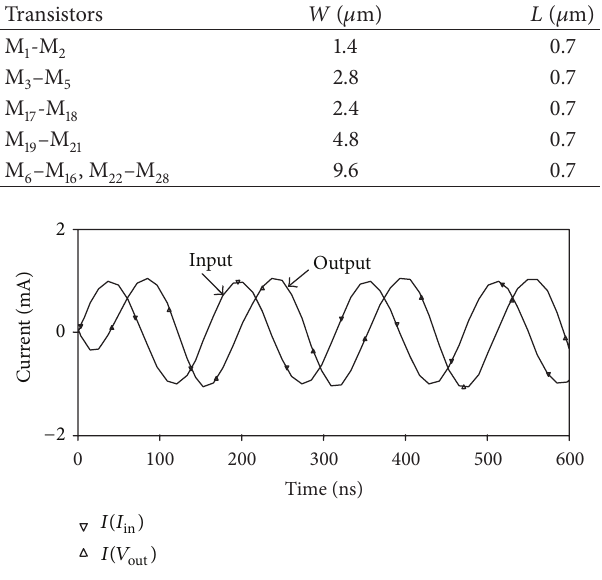
Figure 5: Time-domain input and output responses of all-pass